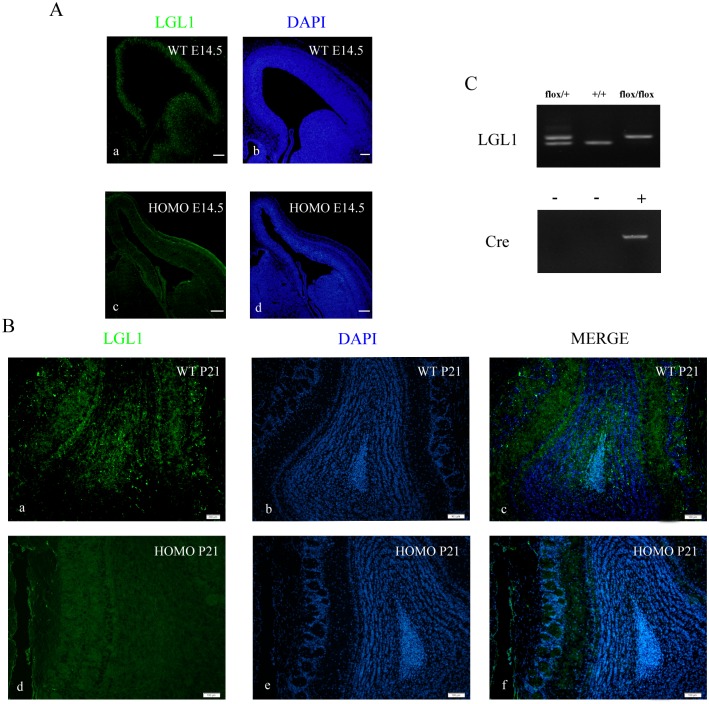
Generation of Lgl1 conditional knockout mice mediated by Pax2 Cre mice.Immunofluorescence staining was performed on frozen sections of E14.5 and P21 wildtype and mutant dLGE using an anti-Lgl1 antibody. Nuclear marker DAPI was used for counter staining (blue). (A) Lgl1 was highly expressed in dLGE of wildtype mice and efficiently deleted in mutant mice. (B) Lgl1 was highly expressed in OB of wildtype mice and efficiently deleted in mutant mice. (C) Genotyping of Lgl1-Pax2 Cre cko mice via PCR. Lanes: heterozygous (Flox/+), homozygous (Flox/Flox) and wildtype (+/+) mice. Scale bars represent 50 μm.